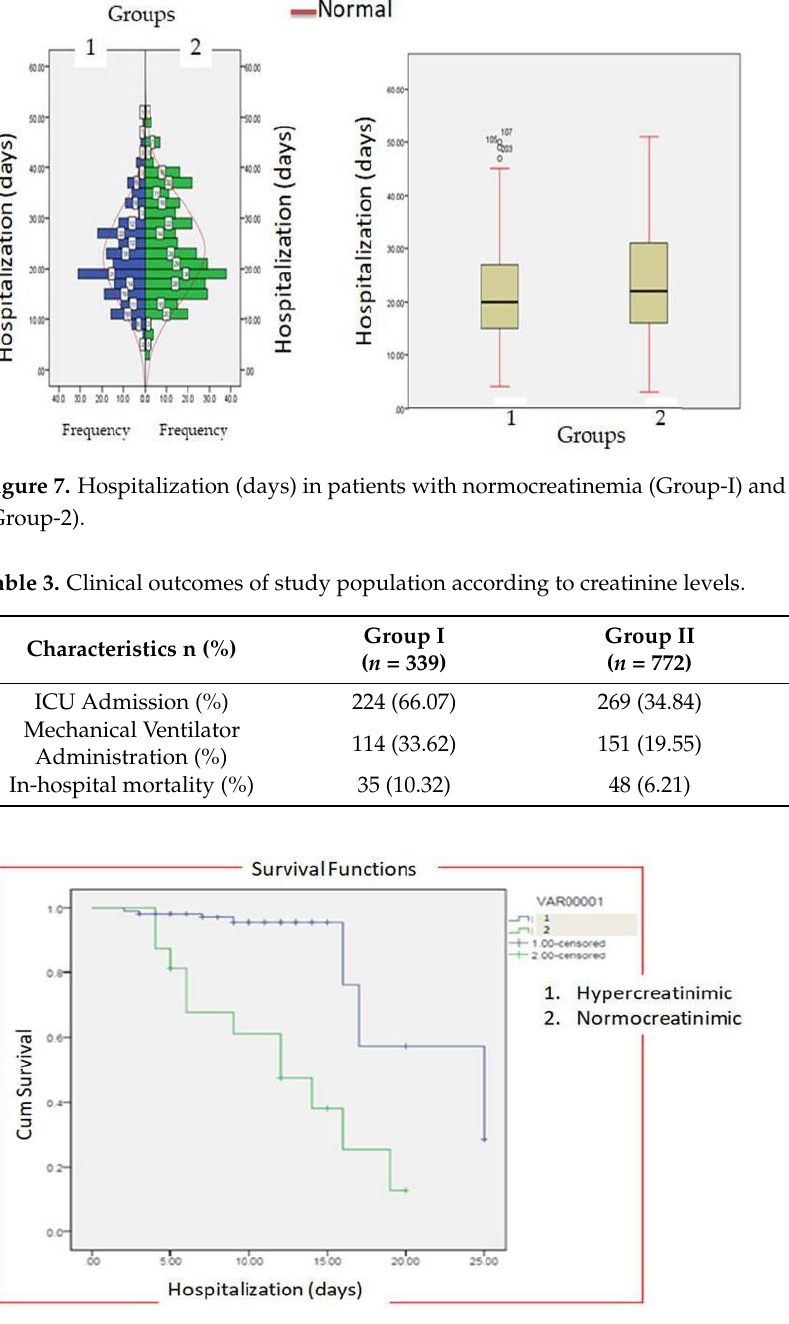
Figure 8. Risk-adjusted Cox regression analysis curves through 25 days for patients with COVID-19 stratified by normocreatinemia (Group-I) and hypercreatinemia (Group-2). Table 3. Clinical outcomes of study population according to creatinine levels.